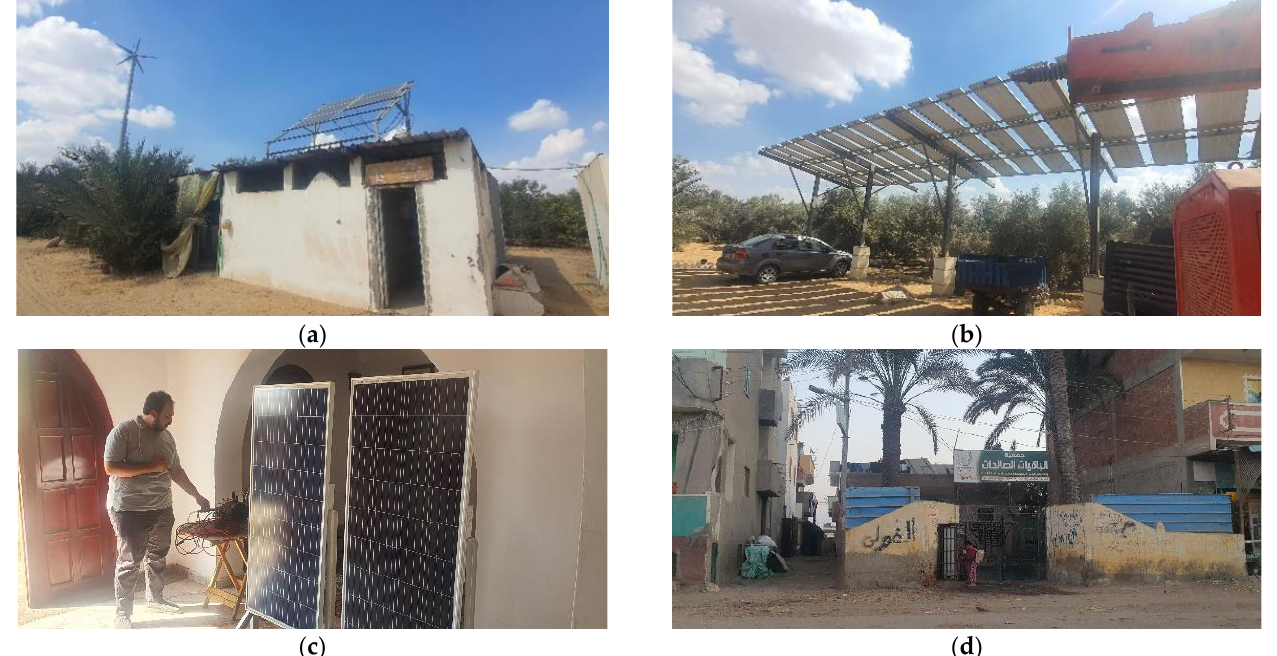
Figure 7. Different implementations promote the REC concept in rural Egypt. ( a ) A hybrid off-grid system. ( b ) Multi-function land use: parking shading and producing electricity to balance consumption in the adjacent activity (solar pump). ( c ) The manager describes a micro-scale practice to generate green hydrogen. ( d ) The first self-consumption social building in the village and surrounding ones. (Images taken by Ahmed Abouaiana.)